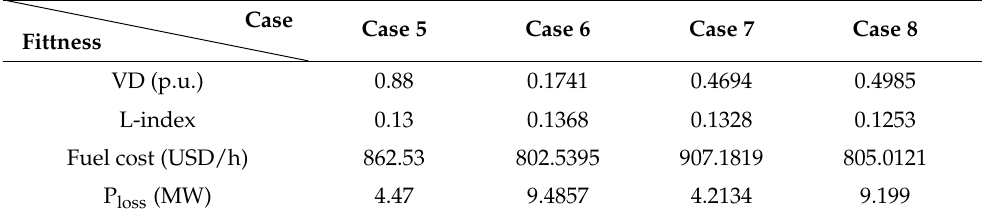
Table 8. Simulation results for multi-objective OPF cases.